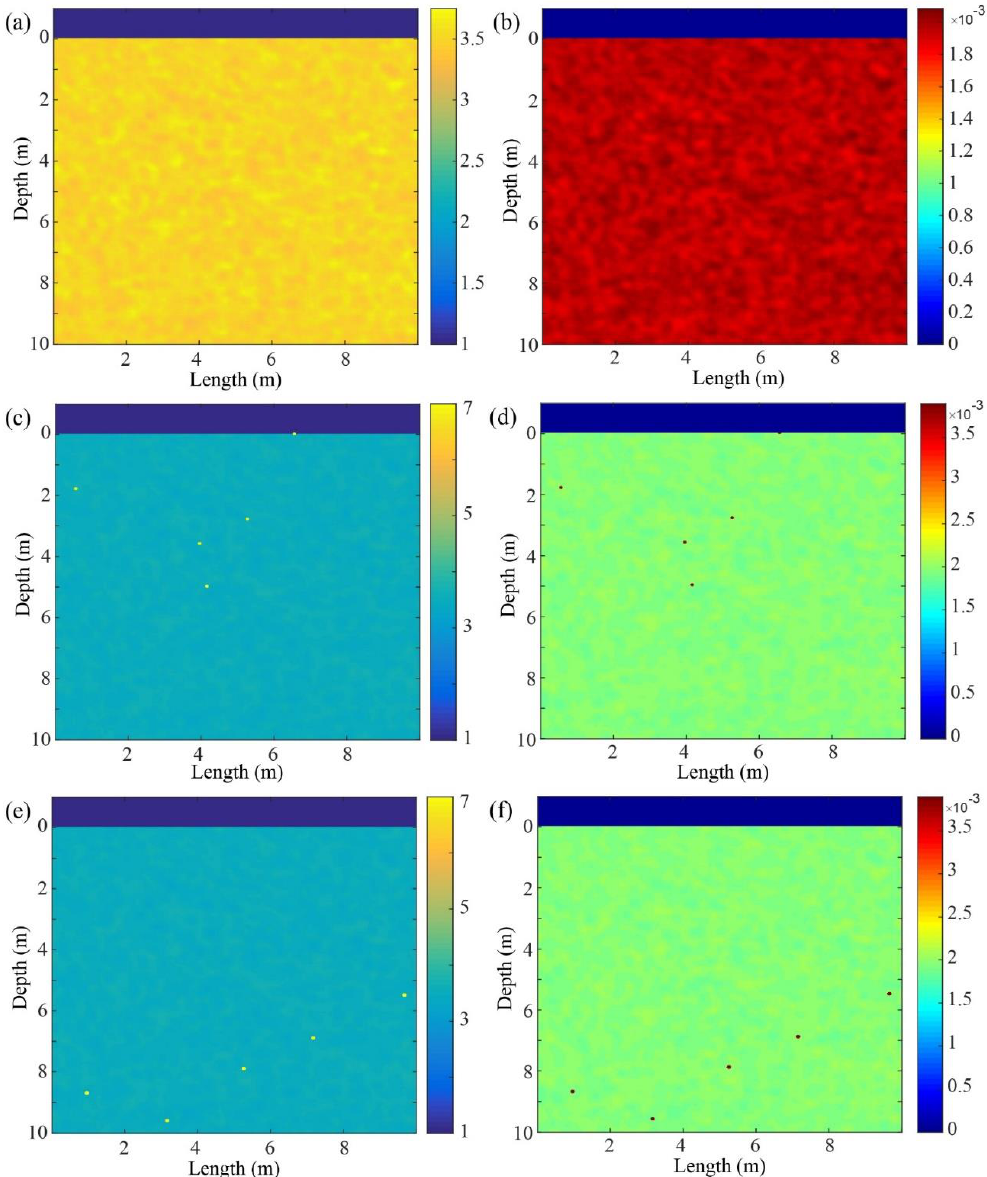
Figure 3. Three simulation models. ( a ) The permittivity of the simulation in Model One. The color bar is the relative permittivity. ( b ) The conductivity of the simulation in Model One. The color bar is the conductivity, and the unit of conductivity is in Siemens/meter. ( c ) and ( d ) are the permittivity and the conductivity of the simulation in Model Two, respectively. ( e ) and ( f ) are the permittivity and the conductivity of the simulation in Model Three, respectively.